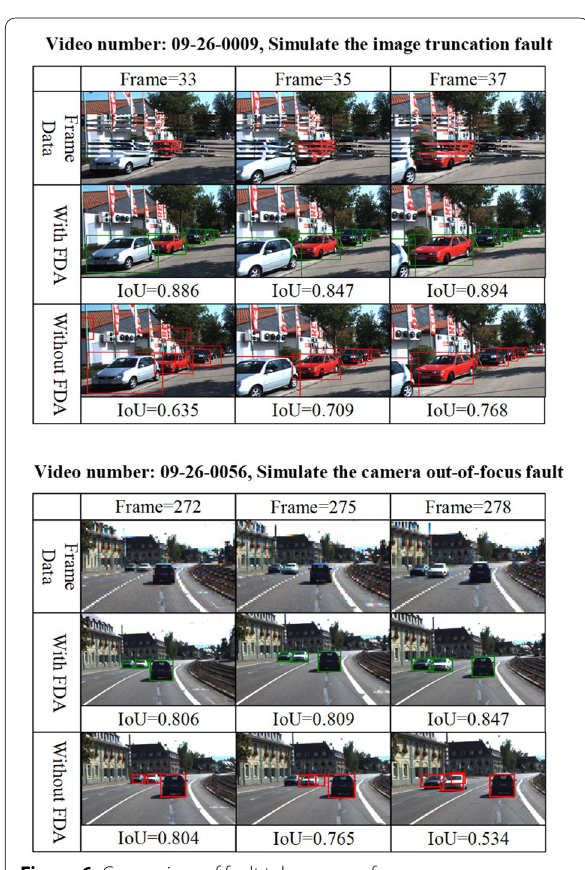
Figure 6 Comparison of fault tolerance